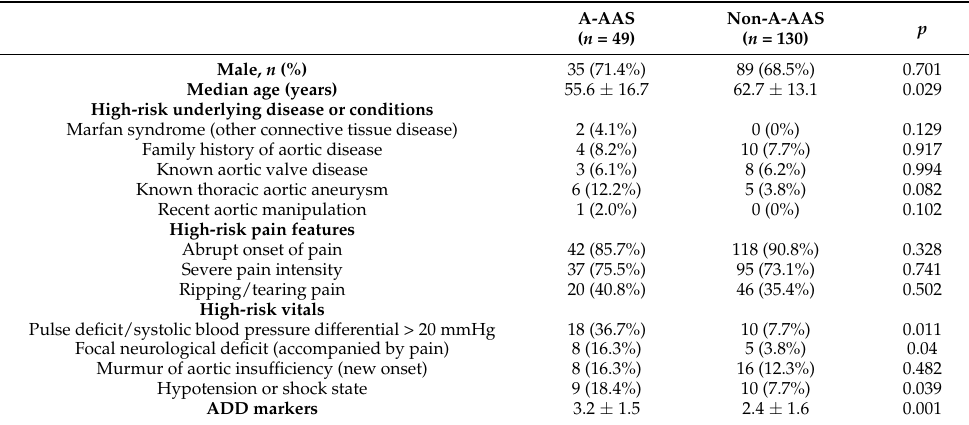
Table 1. Baseline clinical characteristics and ADD markers of study